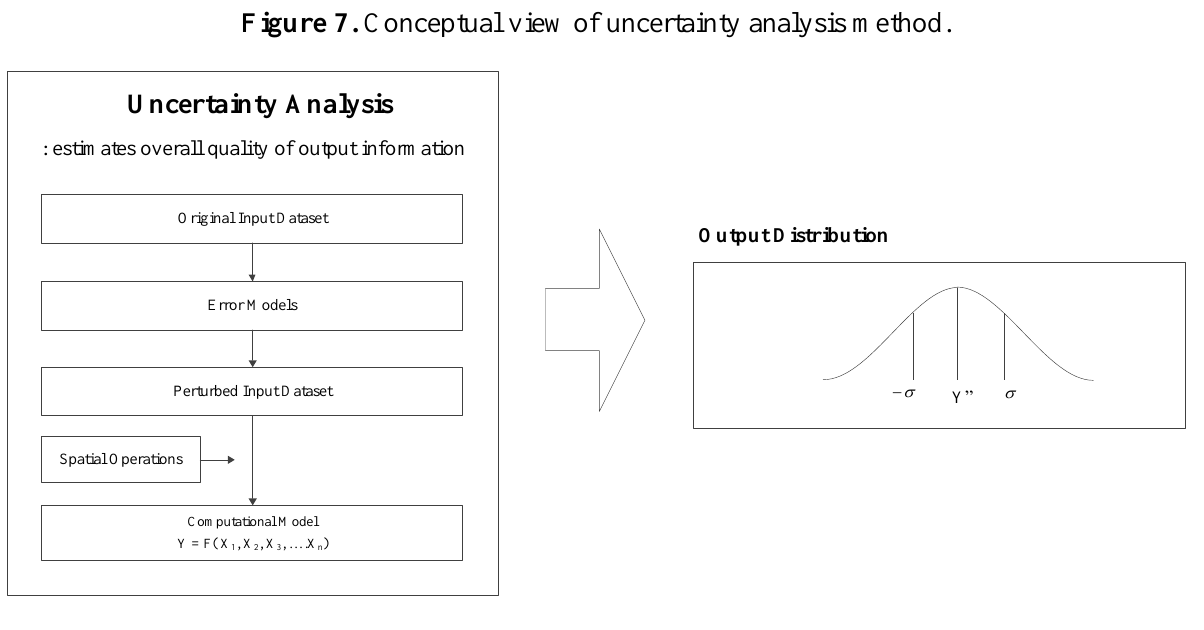
Figure 8. Conceptual view of sensitivity